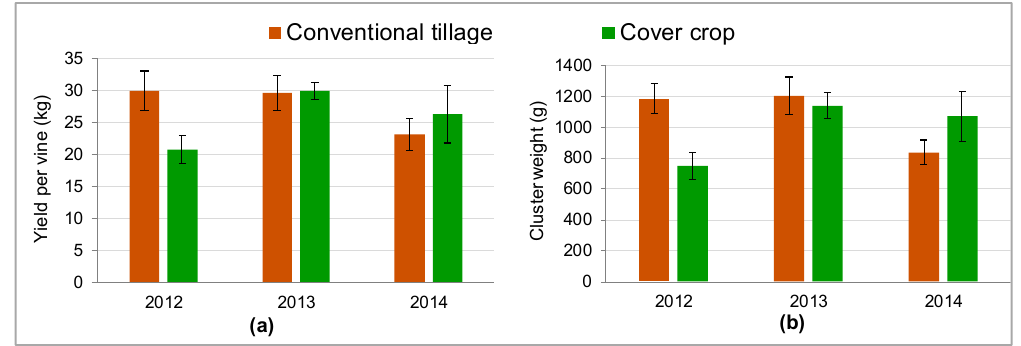
Figure 6. The trend of yield per vine ( a ) and mean cluster weight ( b ) under conventional tillage or cover crop during three years of experimentation. The bar on each column indicates the standard deviation (n = 3).